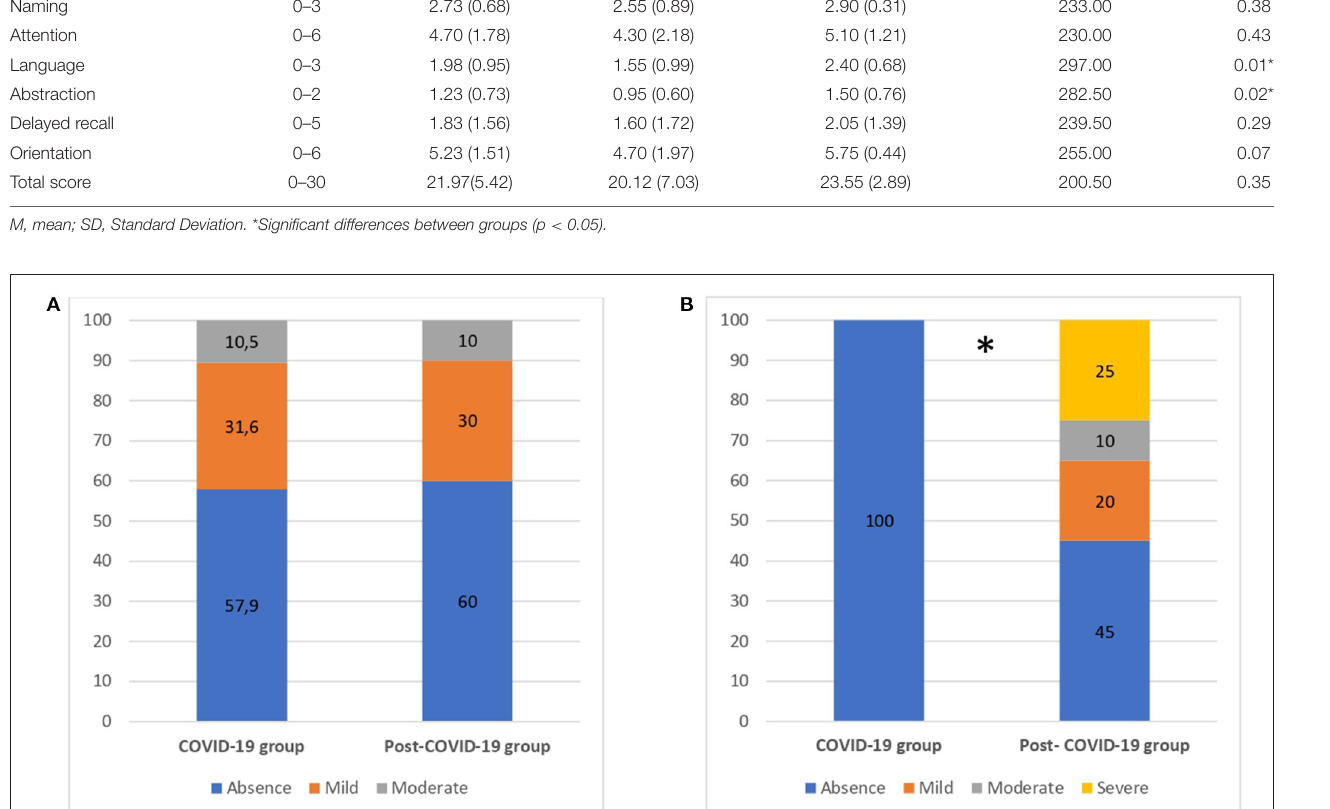
Post COVID-19 group